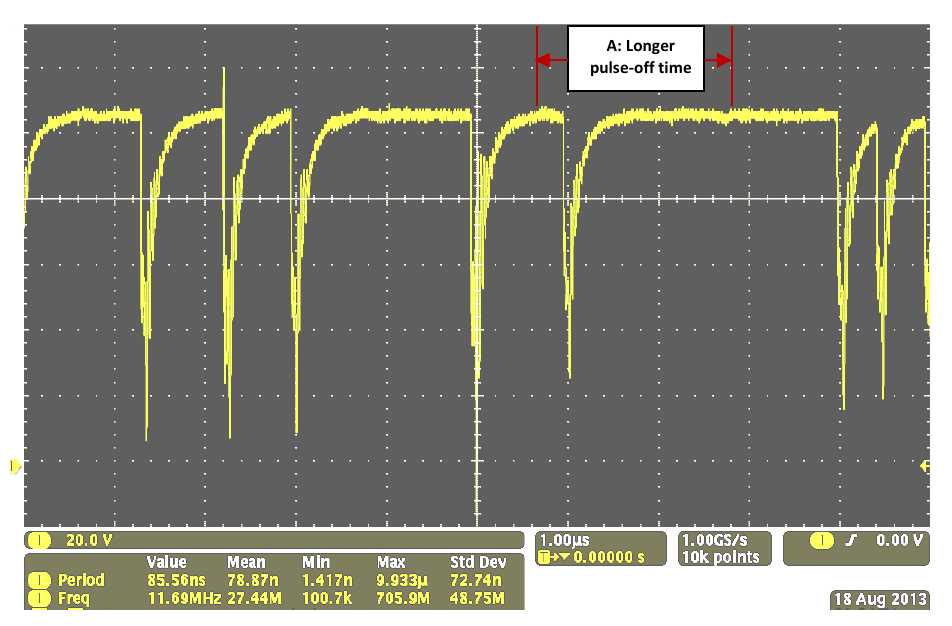
Figure 6: Pulses during cutting ceramics at C = 100 pF and V = 110 V